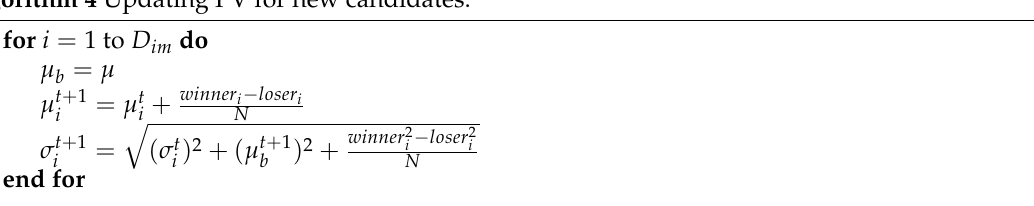
Algorithm 4 Updating PV for new candidates.